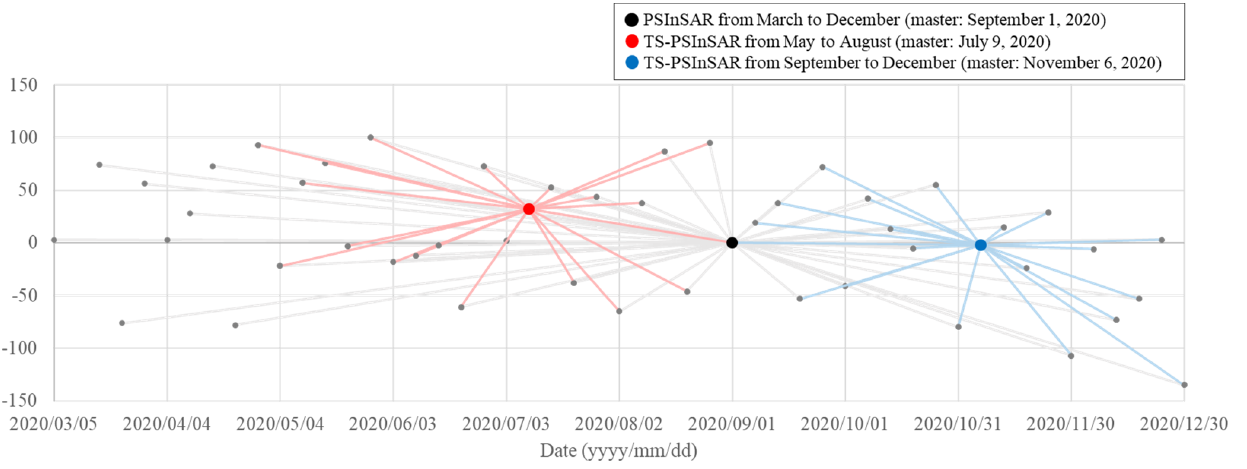
Figure 8. Comparison of PSInSAR result using 10 ‐ month data and TS ‐ PSInSAR results using 4 ‐ month data: ( a ) mean LOS velocity map using 10 ‐ month data from March to December 2020; ( b ) mean LOS velocity map using 4 ‐ month data from May to August 2020; ( c ) mean LOS velocity map using 4 ‐ month data from September to December 2020. Each point indicated by A, B, C, and D is a point from which LOS displacement time series data were obtained in Figure 9, respectively.